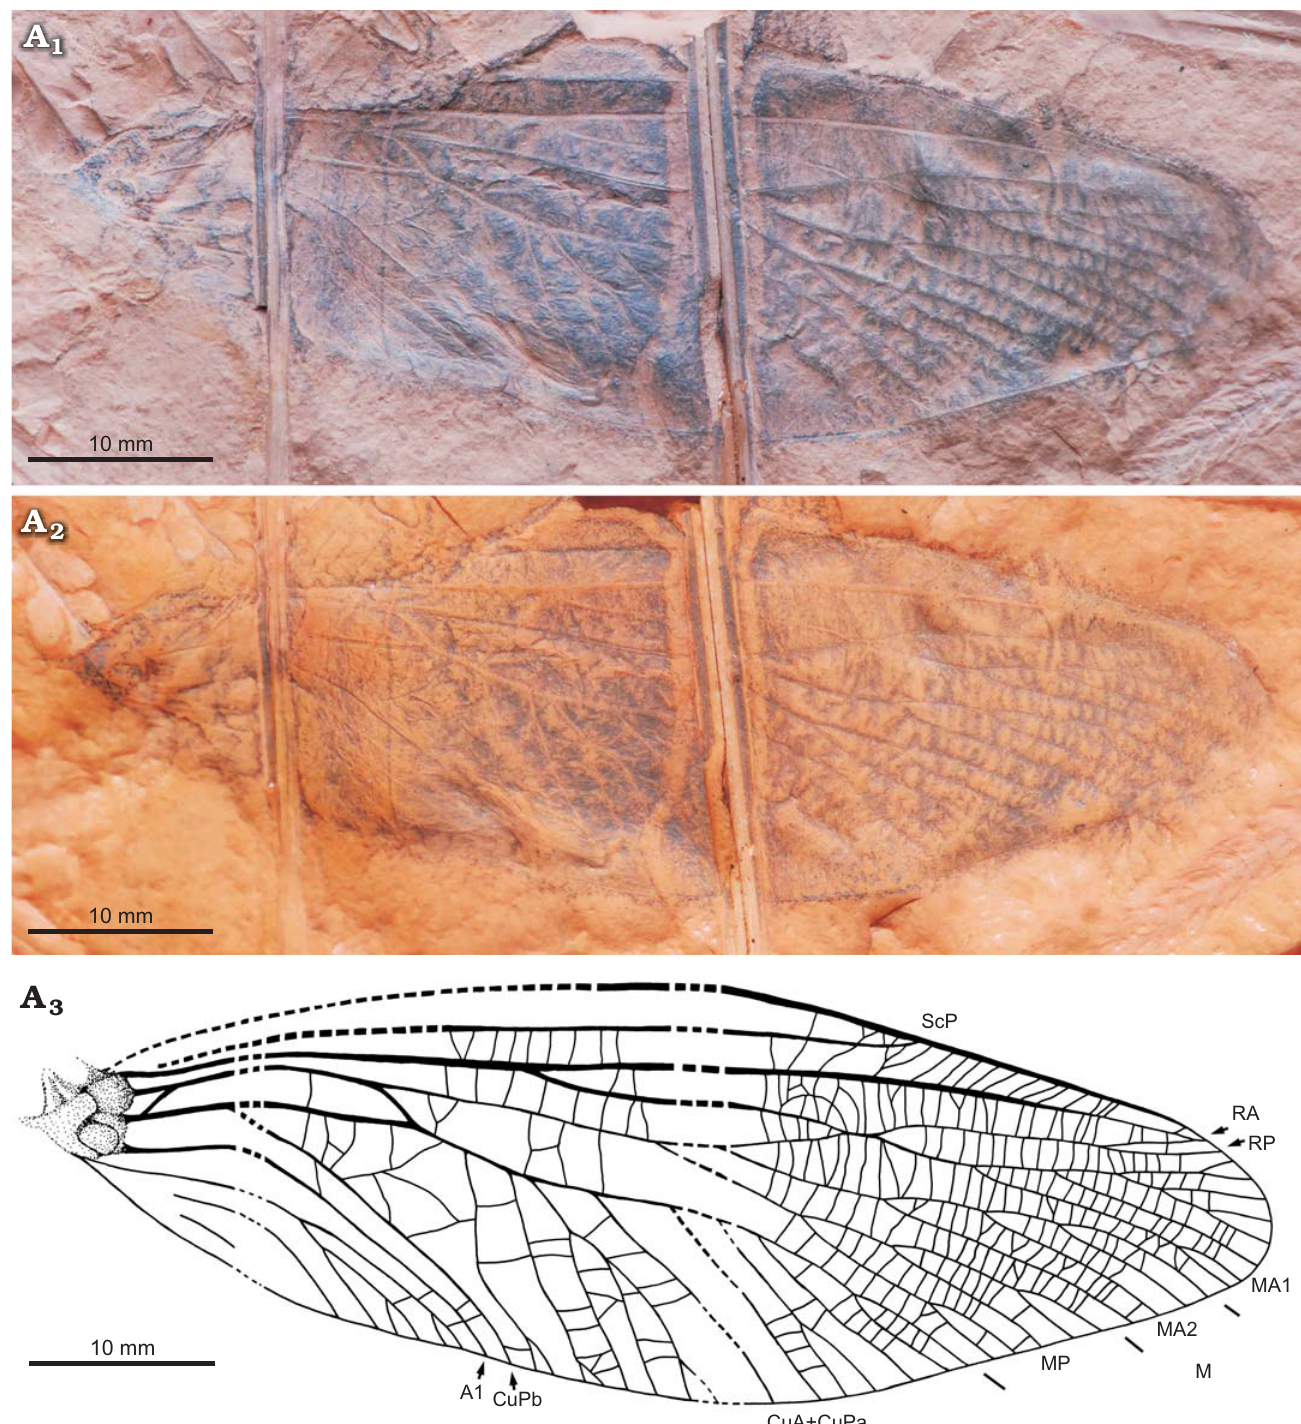
Fig. 1. Forewing venation of archaeorthopteran insect Omaliella polonica sp. nov., holotype (MP ISEA I − F/MP/8/1676/17), Carboniferous, Pen syl- vannian, Duckmantian (Westphalian B), Leszczyny-Czerwionka nearby the Knurów, Upper Silesia, Poland. Photograph in dry state (A 1 ), under a film of ethanol (A 2 ), and explanatory drawing (A 3 ). Abbreviations: A1, first anal vein; CuA, cubital anterior; CuPa/b, anterior/posterior branch of cubital poste- rior; M, media; MA/P, media anterior/posterior; RA/P, radius anterior/posterior; ScP, subcosta terior part of wing is not preserved; proximal part of ScP Description .—Based on fore-wing venation. Nearly com- incomplete due to preservation; ScP reaches anterior wing plete wing broadest approximately in the middle with origi- margin in two thirds along the length of the wing, without nally hyaline membrane and numerous transverse or slightly discer nible anterior branches; space between ScP and costal oblique cross veins; ScA unknown because the basal an-